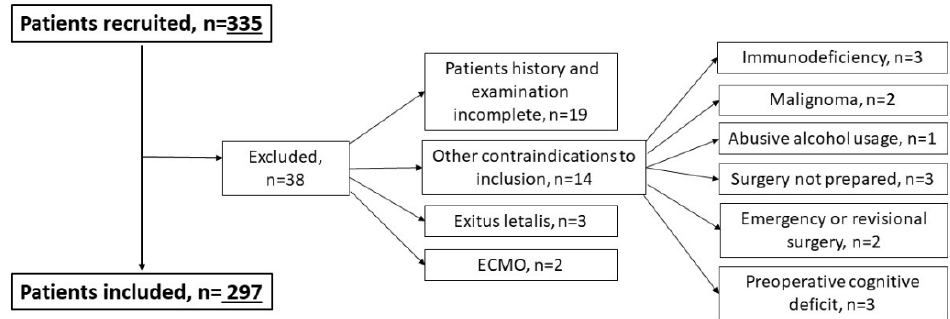
Figure 1. Section flow chart with reasons for study exclusion.